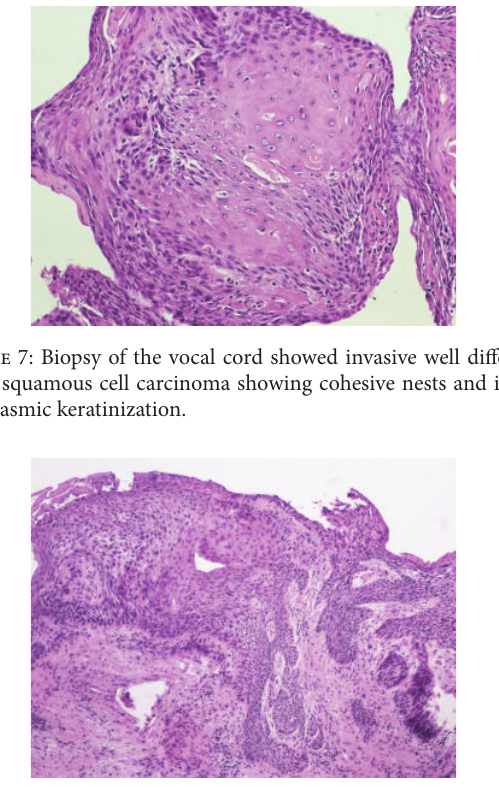
Figure 8: Left vocal cord mass showing deeply invasive, moderately differentiated squamous cell